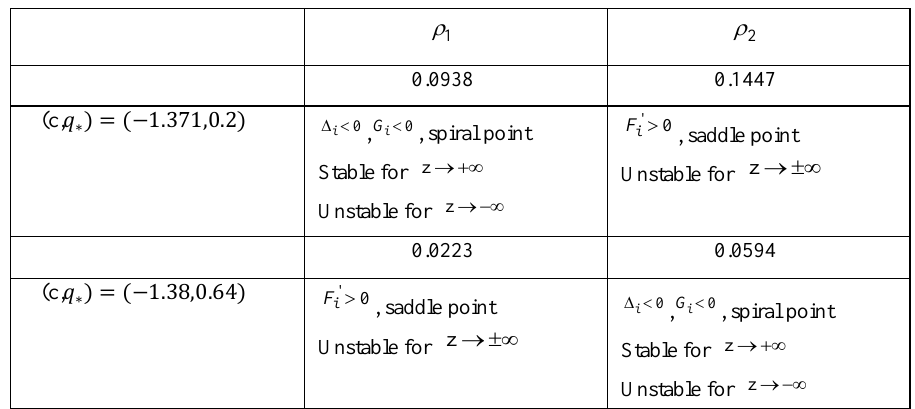
Table 1. Types of equilibrium points and their stability when model parameters are given, ∆ 𝑖 = 𝐺 𝑖2 + 4𝐹 𝑖′ ,𝑖 = 1,2